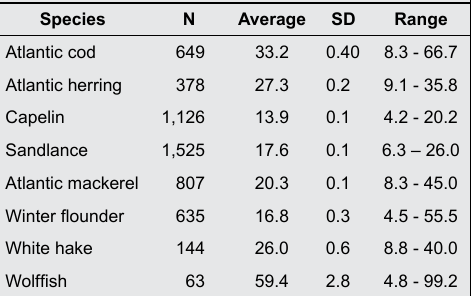
Table 11. Number of measured otoliths (N), average prey length (cm), with standard deviation in parentheses and range of prey lengths (cm) consumed by grey seals in sam- ples collected from the Gulf of St. Lawrence and around Newfoundland between 1985 and 2004. Latin binomial names as in Table